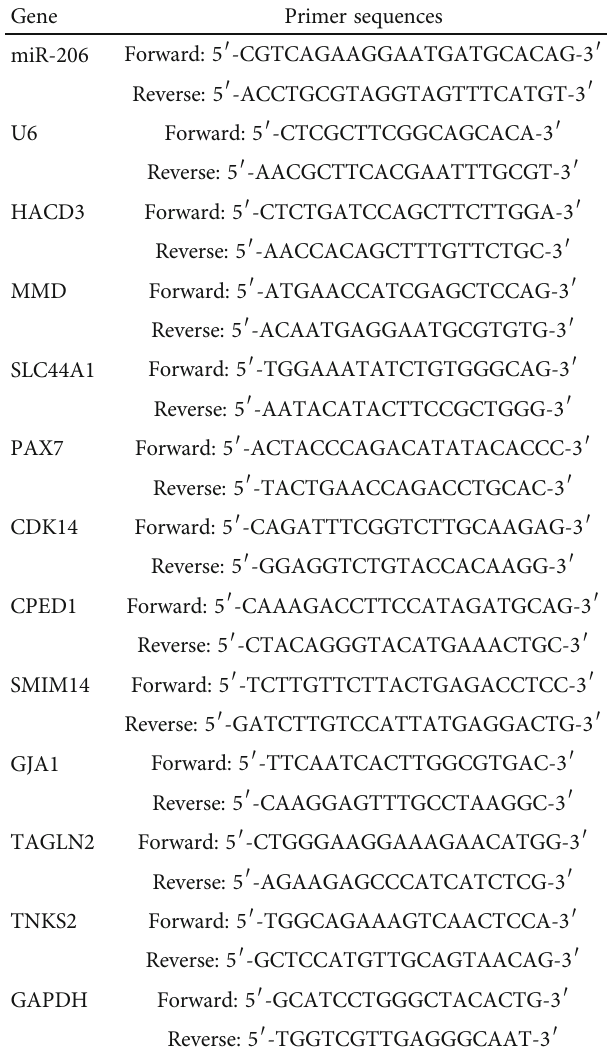
Table 1: Primer sequences for